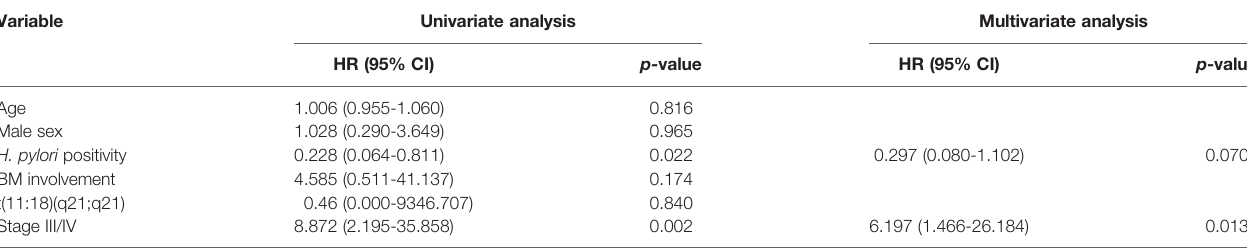
TABLE 4 | Univariate and multivariate analyses of clinical factors associated with overall survival. Variable Univariate